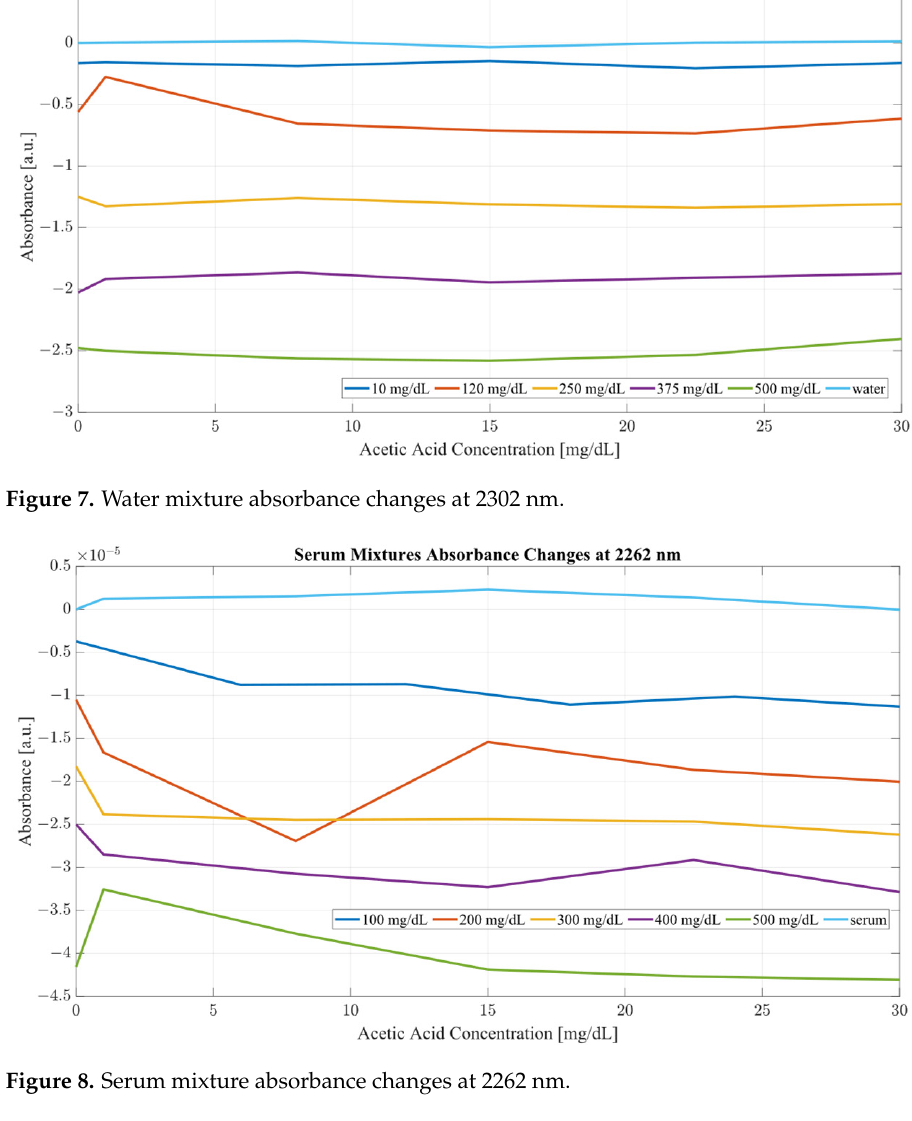
Figure 8. Serum mixture absorbance changes at 2262 nm.